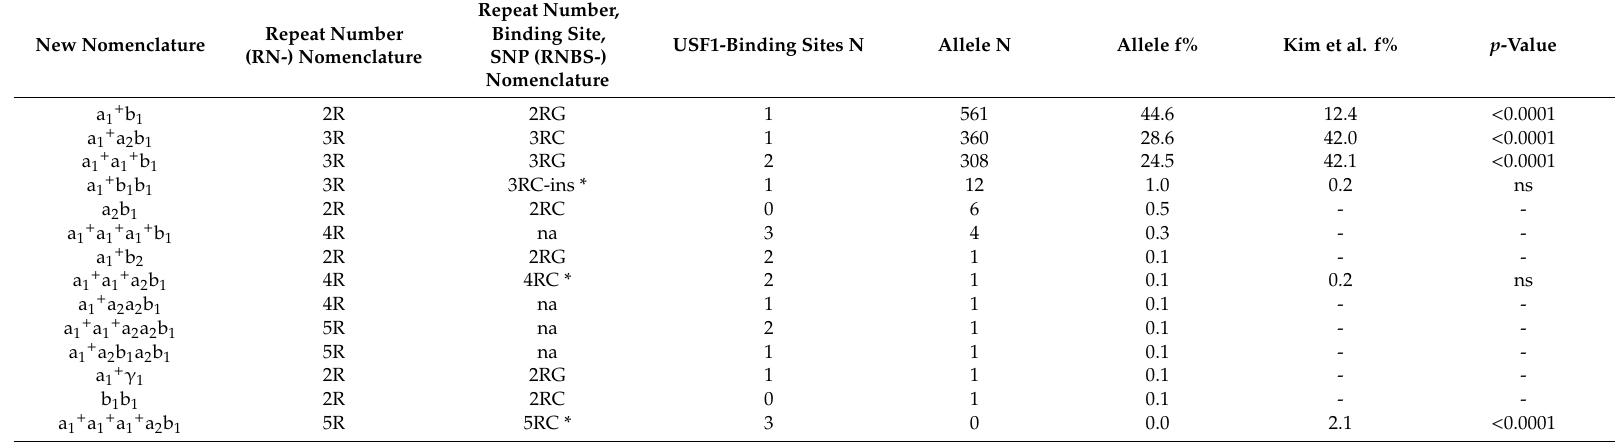
Table 2. Frequencies of TSER (TYMS enhancer region)-polymorphisms. Each of the 13 alleles in our cohort (N = 629) plus one allele ( α 1 + α 1 + α 1 + α 2 β 1 ) only detected in the Japanese cohort (N = 263) previously reported by Kim et al. [8] is listed using the “New”, the “repeat number”(RN-), and the “repeat number, binding site, SNP” (RNBS-) nomenclature (columns 1, 2, and 3; *: allelic designations given by Kim et al. [8]; na: no name could be assigned using this nomenclature). For each allele, the number (N) of USF1 (upstream stimulatory factor)-binding sites (column 4), the number (N) of alleles (column 5), and the allele frequency (f%) (column 6) within the cohort is shown. For comparison, column 7 shows the frequency of the common alleles in a Japanese cohort. Column 8 lists the p -values from Fisher’s exact test for population allele frequency di ff erences between the study cohort and the population from Kim et al.